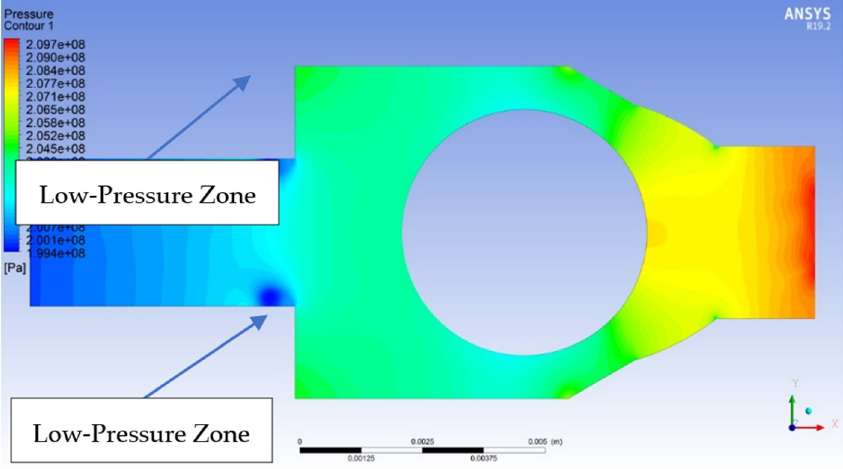
Figure 12. Pressure CFD: Spherical Seat Valve − x = 1.257 [mm], pdn = 2000 [bar] and pup = 2100 [bar].